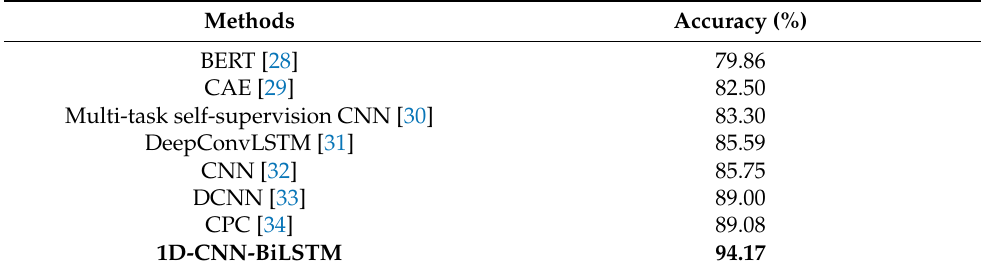
Table 9. Comparative results on the motion sense